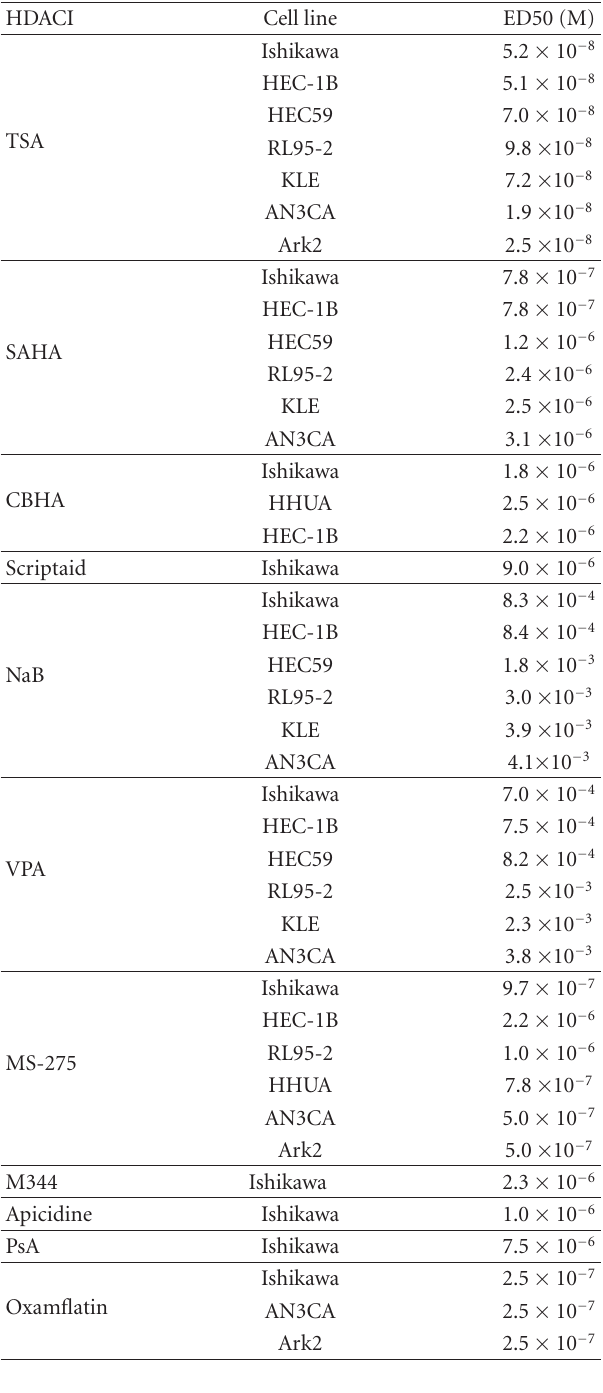
Table 2: Data investigating endometrial cancer cell lines treated with di ff erent classes of